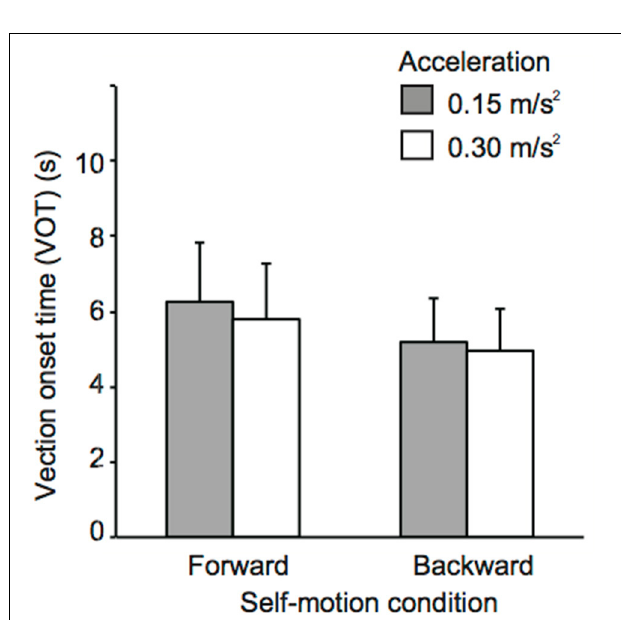
FIGURE 2 | Effects of acceleration on auditory localization in Experiment 1 for the forward (A) and backward (B) conditions. The mean sound positions aligned with participants’ subjective coronal plane are shown as a